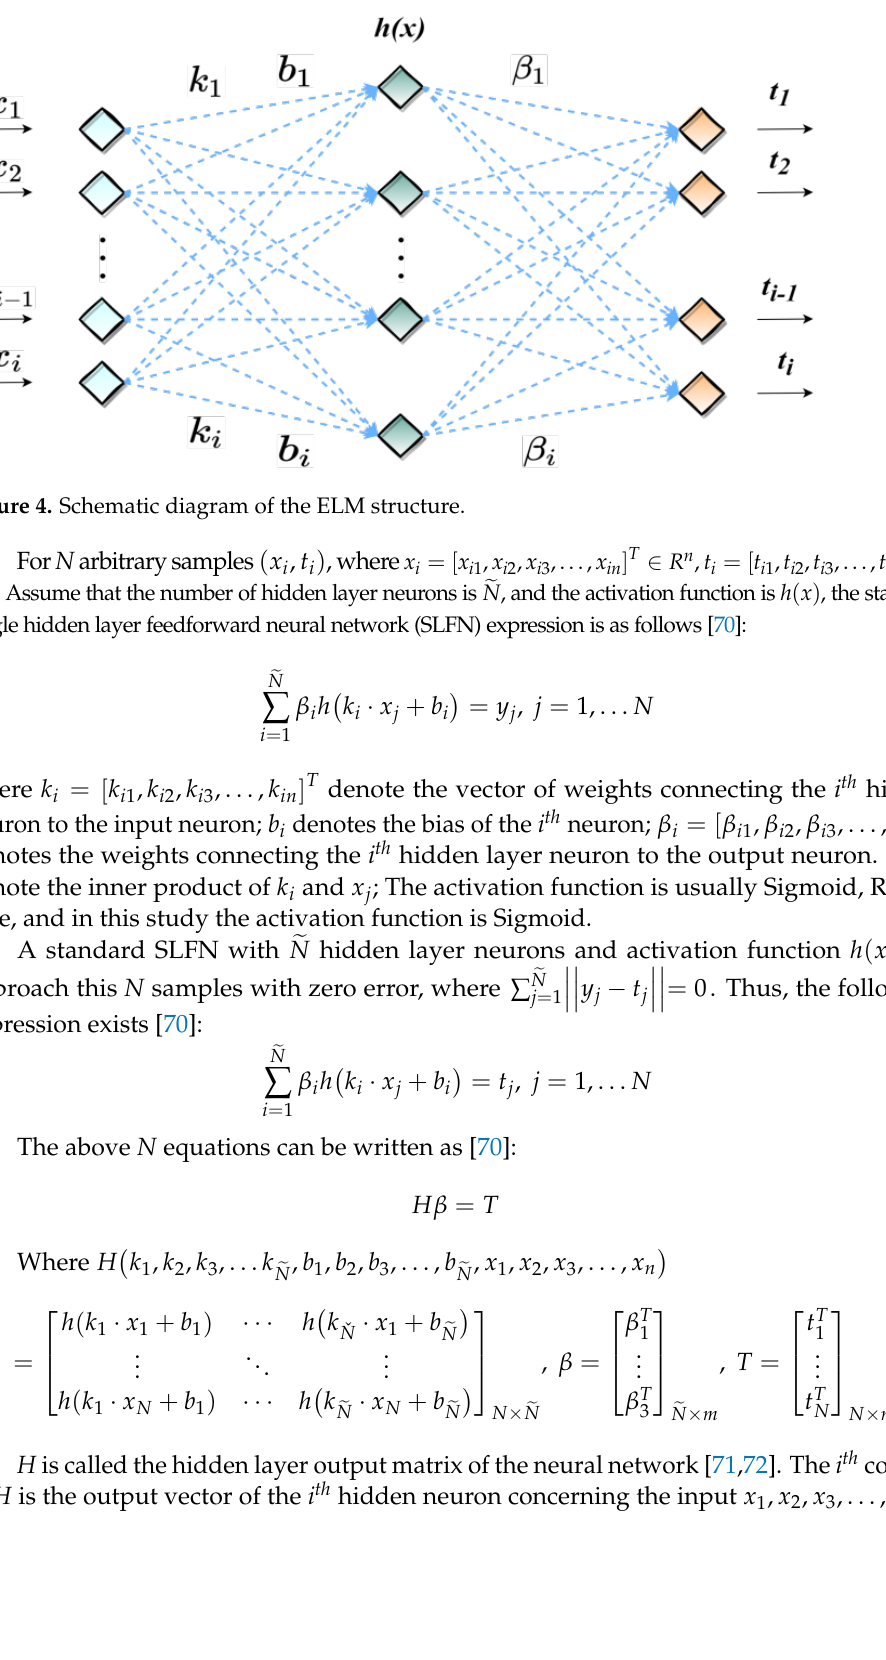
Figure 4. The primary calculation process for ELM is as follows: